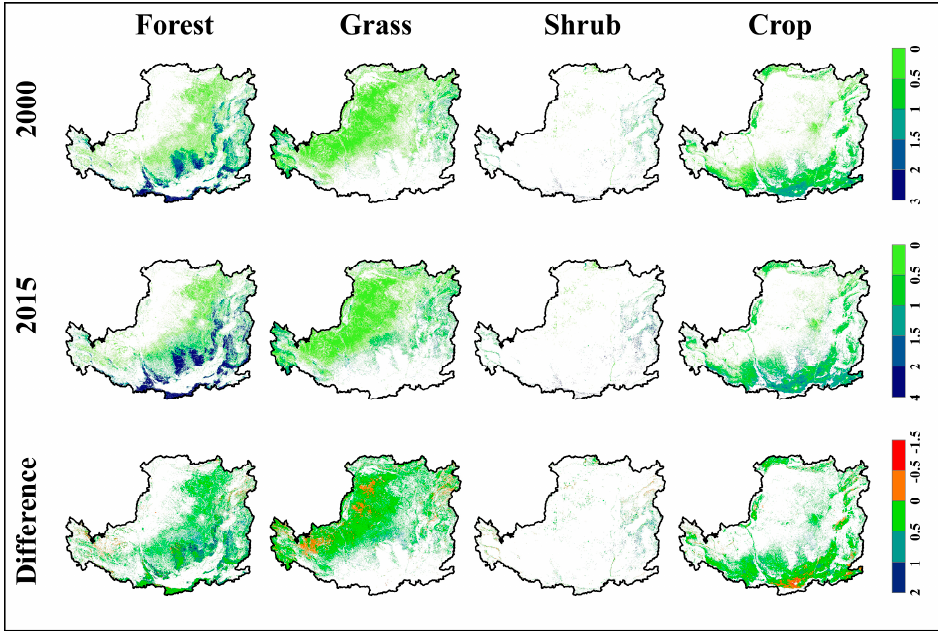
Figure 1. Spatial distribution of the LAI values of different vegetation types for 2000 and 2015. The bottom row shows differences between 2000 and 2015 (calculated as 2015 minus 2000).